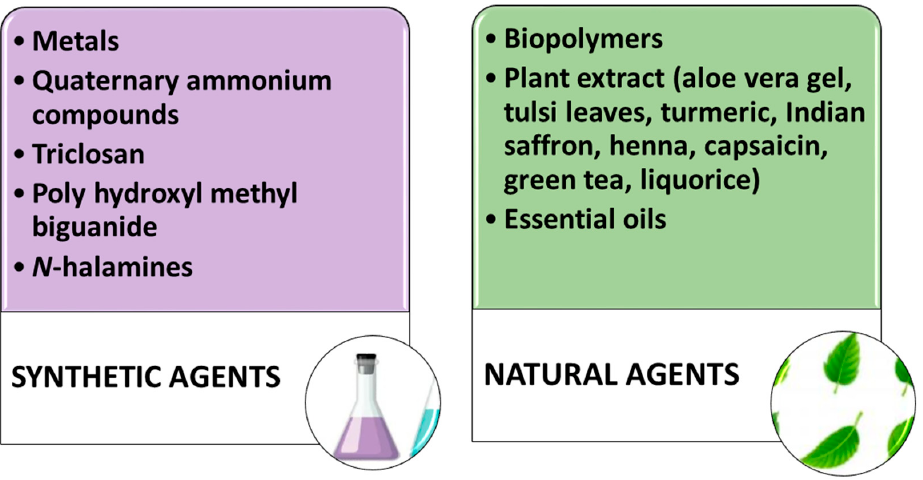
Figure 6. Common antimicrobial textile finishing agents.